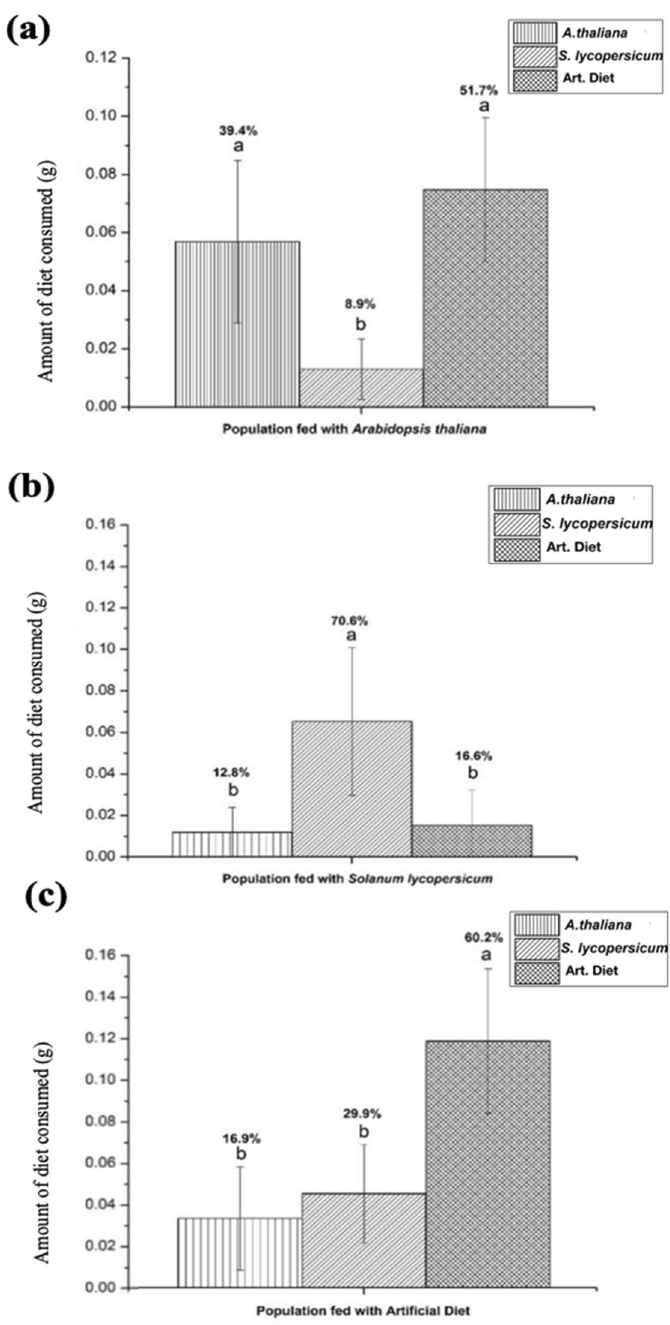
Figure 2. Weight of each diet administered after exposure to insect populations during the feeding preference experiment. Insect populations used in this assay were previously fed with a specific diet of A. thaliana leaves ( a ), S. lycopersicum leaves ( b ) or with an artificial diet ( c ). Each bar corresponds to the average weight change of each diet after feeding (n = 10). The different populations are represented on the x-axis. ANOVA (F test) were conducted to determine significance. Each letter at the top of error bars represents the mean difference after a Tukey post-hoc test at the p < 0.05 significance level. The percentages above the bars in each graph correspond to percent-consumed of each food, per colony during the